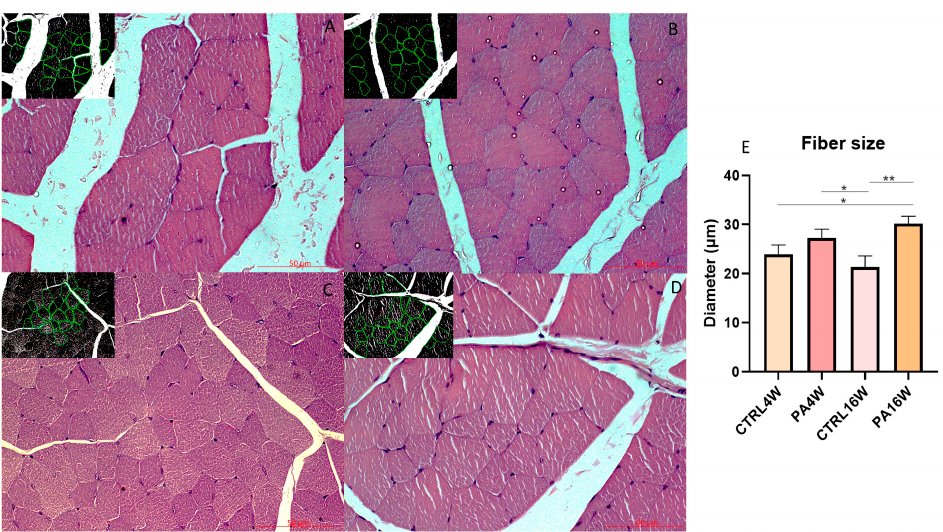
Figure 4. Hematoxylin and eosin staining ( A – D ) and morphometric analysis of the diameter ( µ m) (mean ± SD) of the muscle fibers ( E ). ( A – D ) ( A ) group CTRL4W and in the inset morphometric analysis by the software; ( B ) group PA4W and in the inset morphometric analysis by the software; ( C ) group CTRL16W and in the inset morphometric analysis by the software; ( D ) group PA16W and in the inset morphometric analysis by the software. ( E ) The morphometric analysis highlights a significant hypertrophy of the groups PA16W (30.46 ± 1.43 µ m) (** p < 0.0001), and to PA4W (* p < 0.001) when compared to CTRL16W (21.39 ± 2.19 µ m). Comparison between CTRL4W and PA16W highlights a significant hypertrophy of the latter group (* p < 0.001). No other comparisons show to be significant. Data were tested for normality with the Kolmogorov–Smirnov and Shapiro– Wilk test, and differences between experimental groups were evaluated by using one-way ANOVA, followed by Tukey’s multiple comparison post hoc test. Lens magnification: × 20. Scale bars: 50 µ